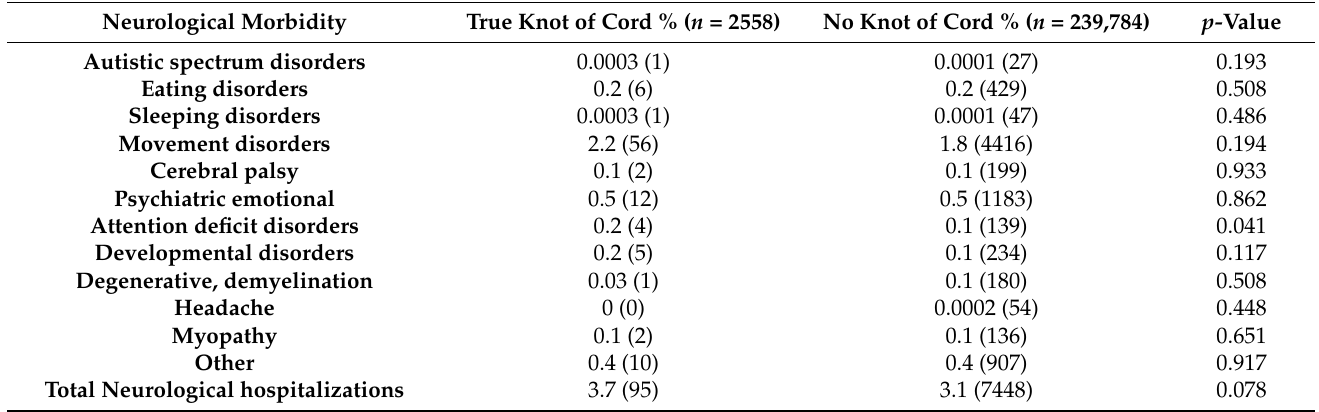
Table 3. Long term neurological hospitalizations of the offspring born with and without true knot of the umbilical cord.